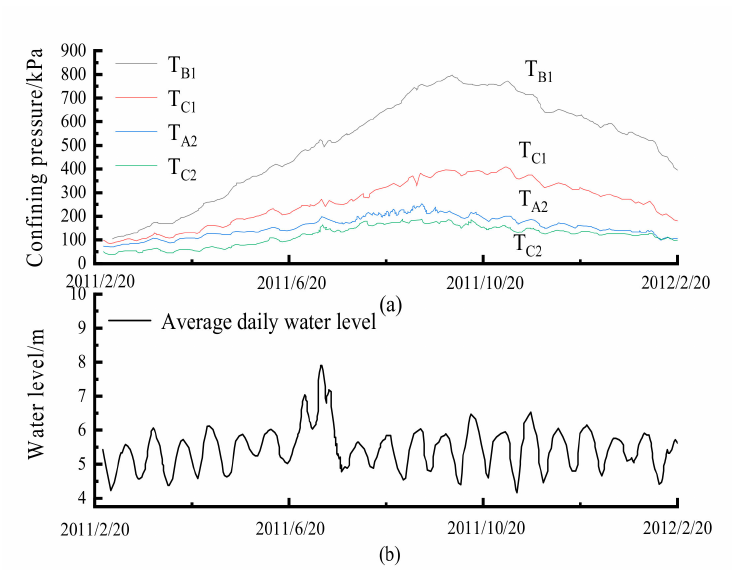
Figure 7. Variations in confining pressure from cross-river tunnel loading: ( a ) Confining pressure; ( b ) Water